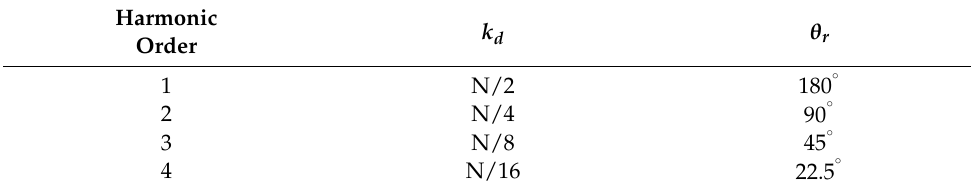
Table 1. Parameters for delay signal cancellation (DSC)